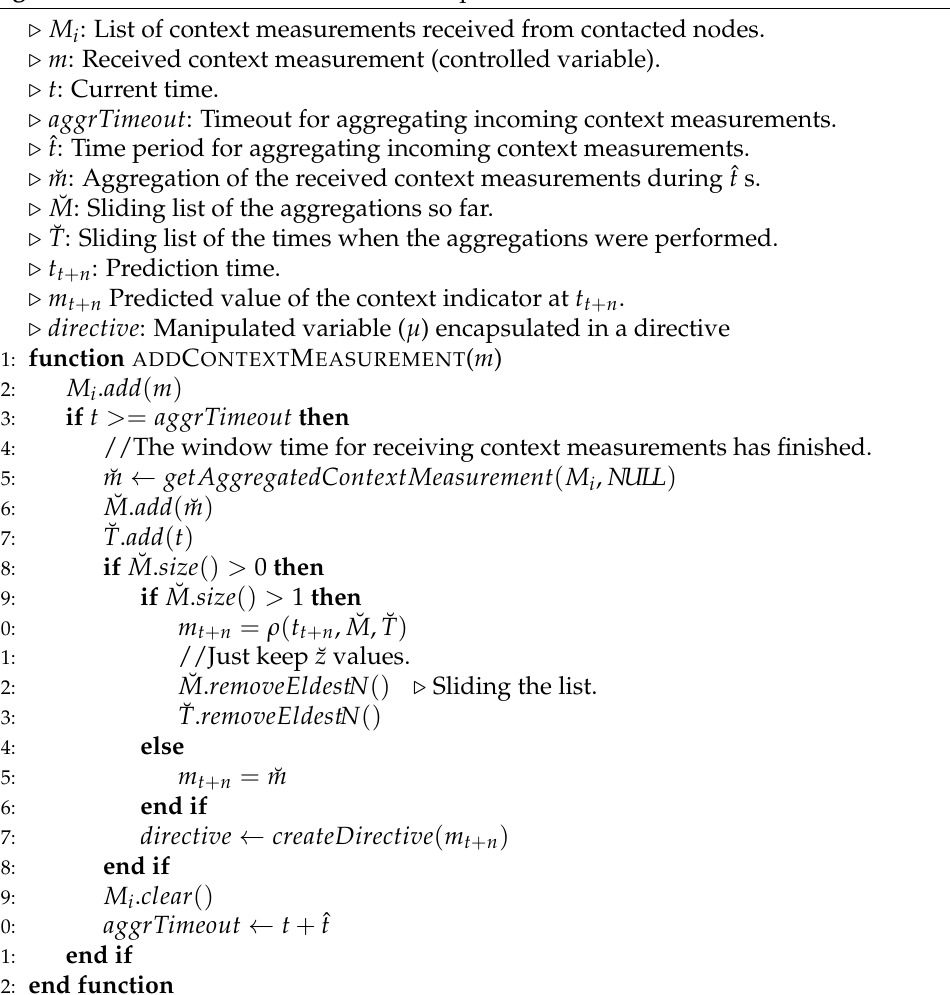
Algorithm 2 Controller’s context indicator